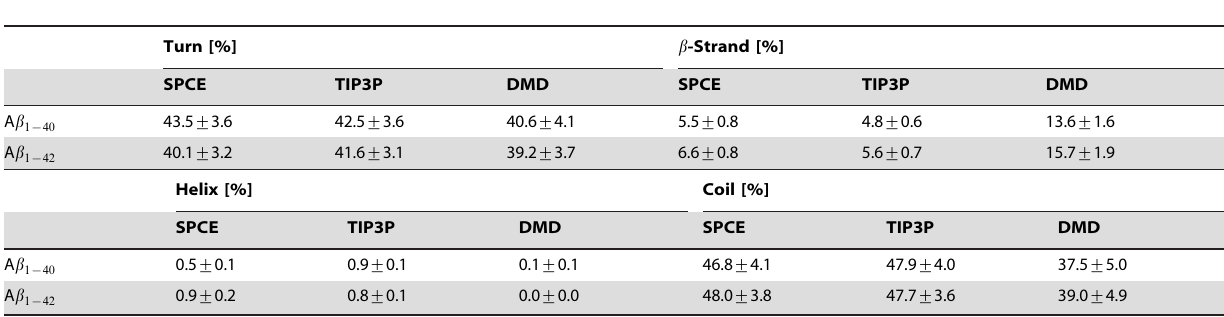
Table 3. Average turn, b -strand, helical, and coil propensities within A b approach with each of the two water models and the DMD approach.